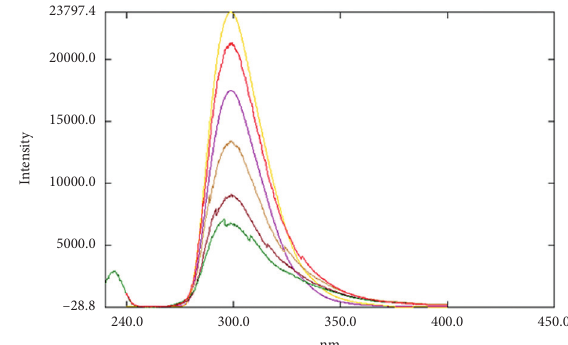
Figure 3: Overlay of EFN calibrators (500–5000ng/mL) at emission (299.4 nm) after excitation at 226.5nm before subtracting the blank fluorescence intensity to calculate the relative fluores- cence intensity for all